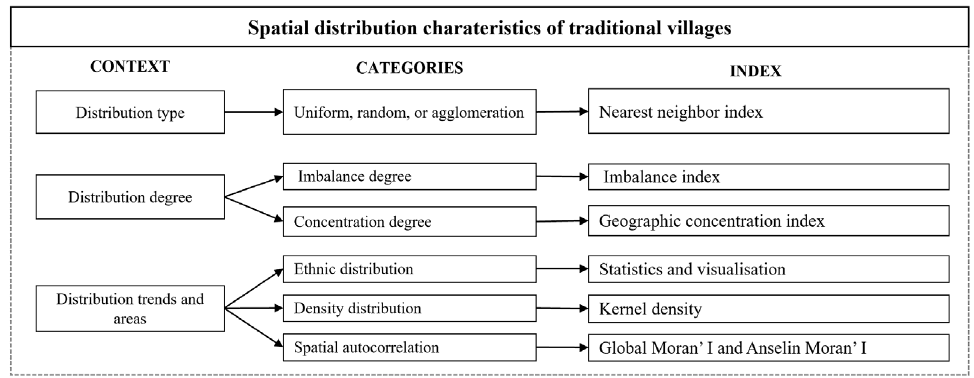
Figure 2. Methodology presentation on the spatial distribution characteristics of traditional villages .